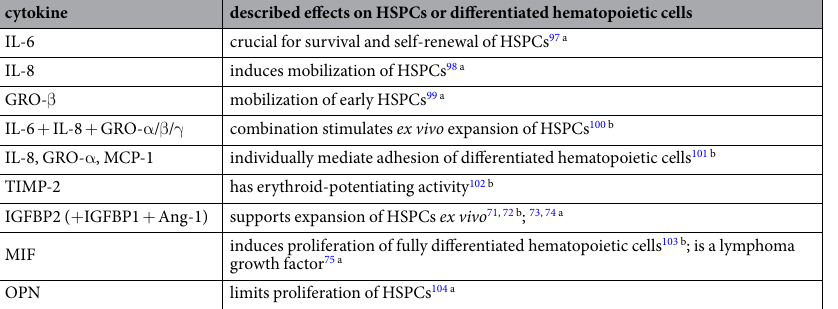
Table 1. Described effects of differentially abundant cytokines on HSPCs or hematopoietic cells. a In the murine system. b In human